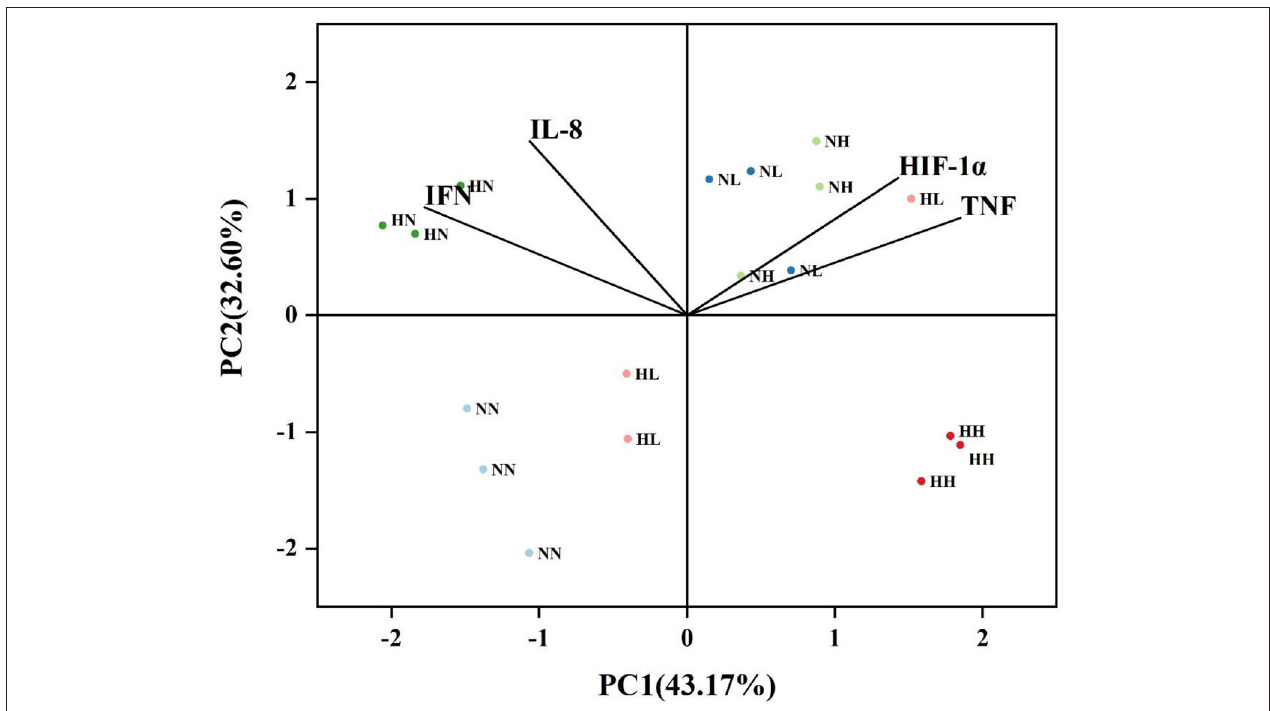
FIGURE 5 | The PCA of P. fulvidraco for 15 days of exposure (NN: normoxia + 0 MPs, NL: normoxia + 0.115 µ g/L MPs, NH: normoxia + 11.5 µ g/L MPs, HN: hypoxia + 0 MPs, HL: hypoxia + 0.115 µ g/L MPs, and HH: hypoxia + 11.5 µ g/L MPs).